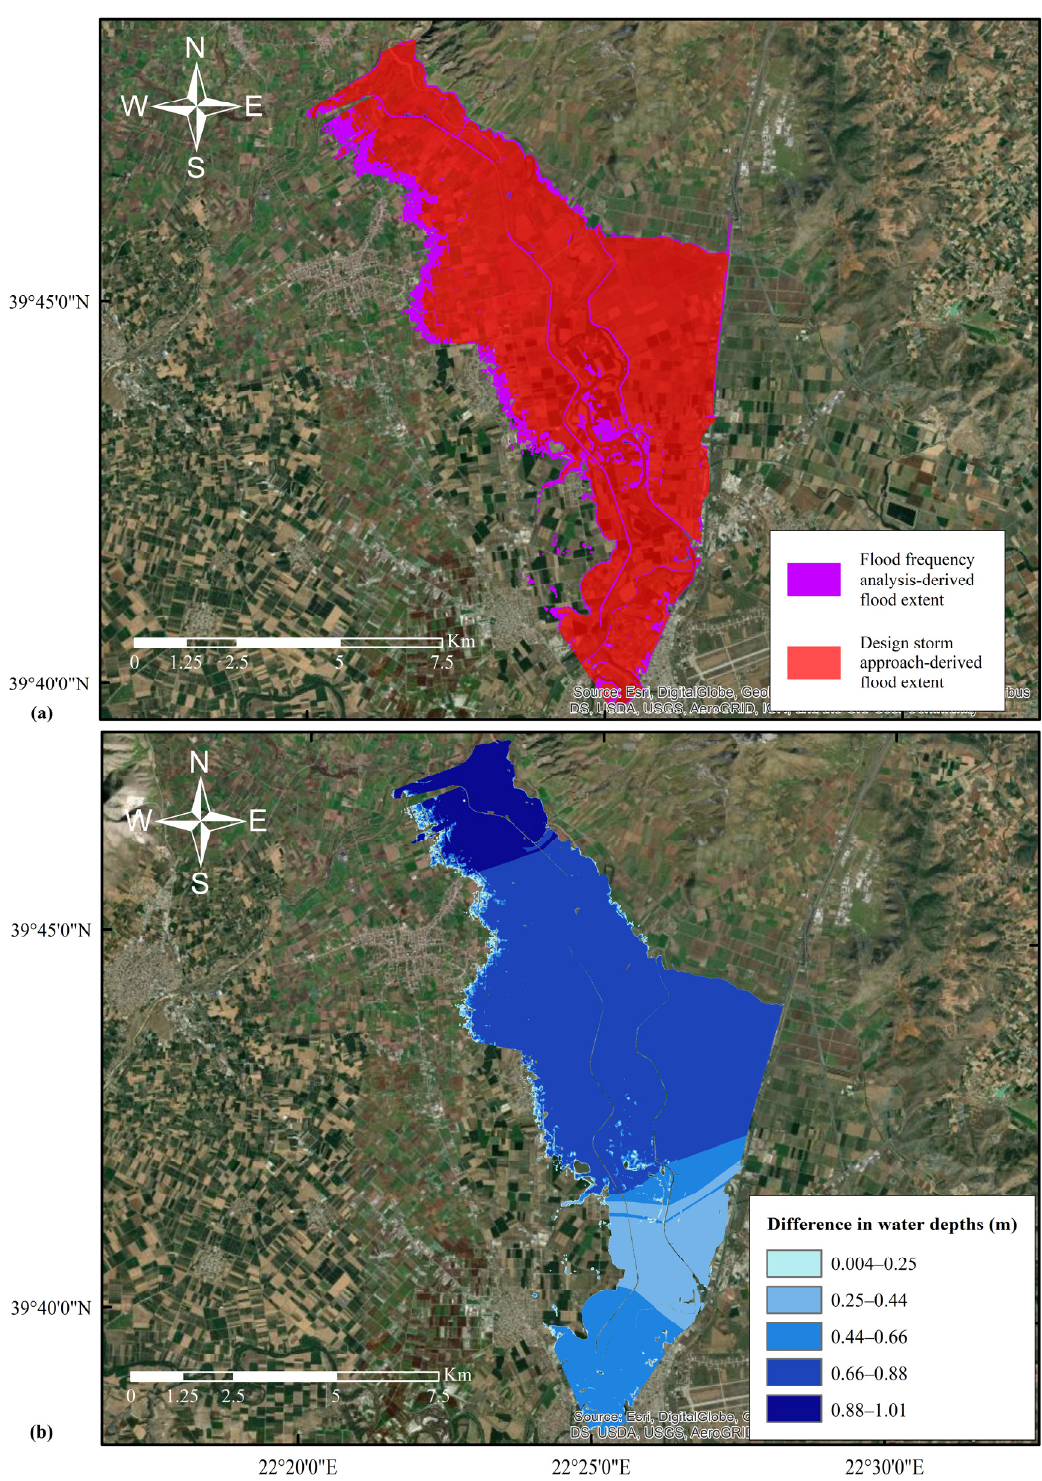
Figure 8. Difference between design storm approach and continuous simulation and flood frequency analysis approach with respect to the ( a ) flood extents and ( b ) inundation depths downstream of the catchment.